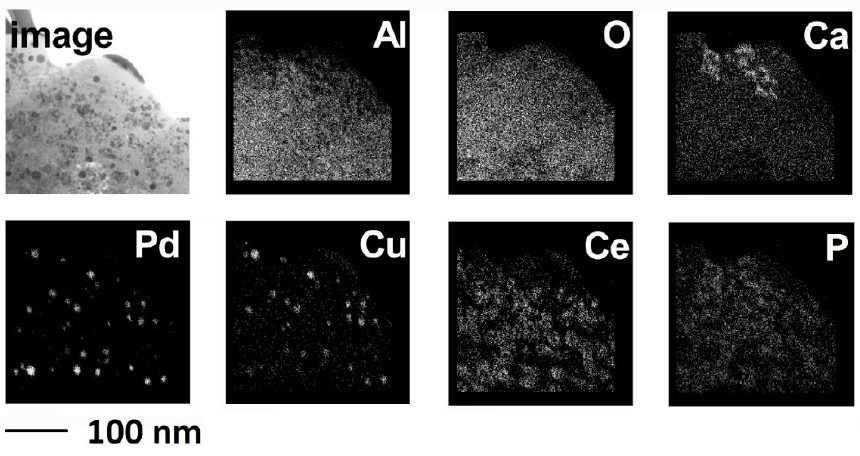
Figure 17. The cross-sectional TEM-EDS map of the inlet natural gas sample.